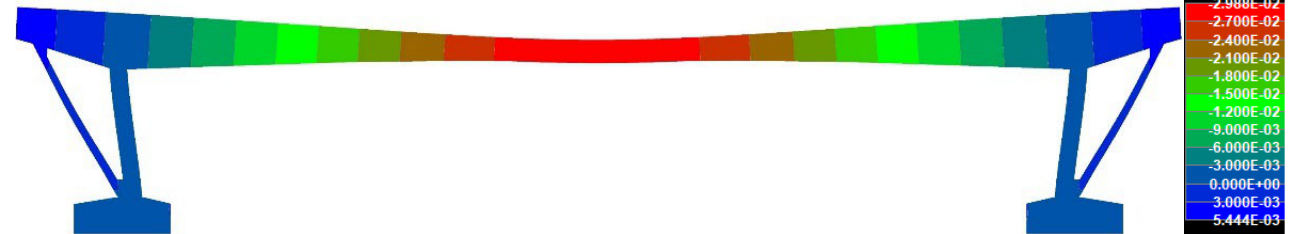
Figure 20. Deflection [m] resulting from the dead load (excluding rheology of concrete).